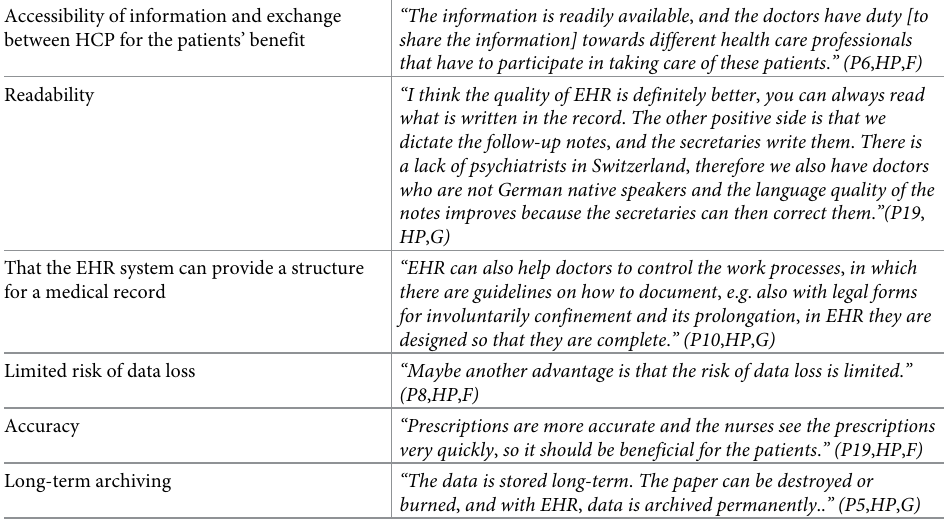
Table 1. Overview of advantages of EHR in clinical work and technological advantages. Accessibility of information and exchange between HCP for the patients’